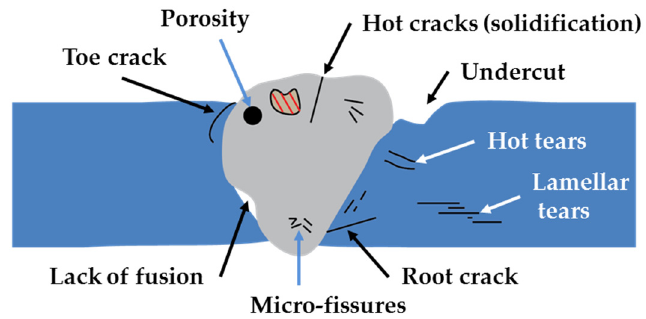
Figure 3. Schematic representation of typical weld defects (adapted from [80]).